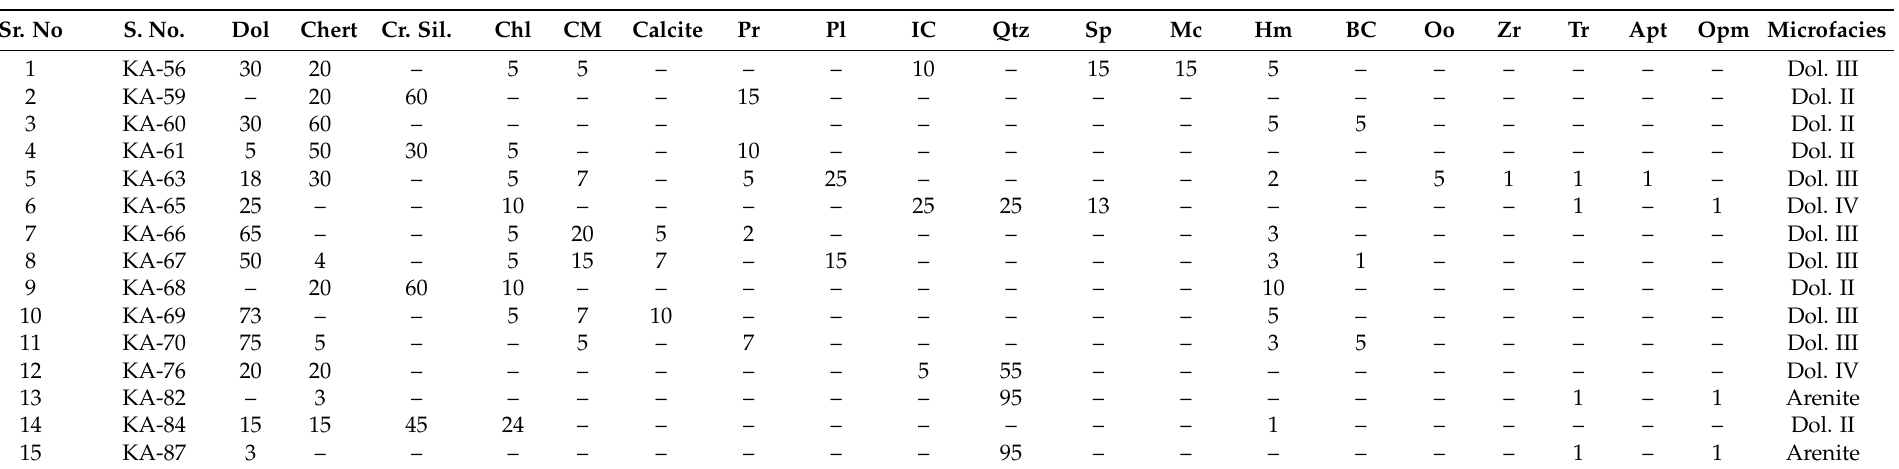
Table 3. Modal mineralogical composition of the Abbottabad Formation, Kamsar section, Muzaffarabad. Sr.